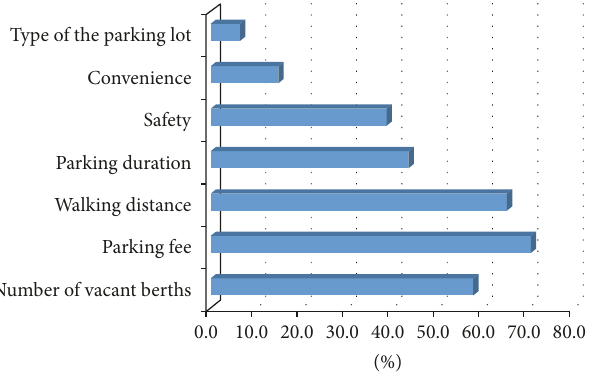
Figure 2: Statistical distribution of factors concerned most.